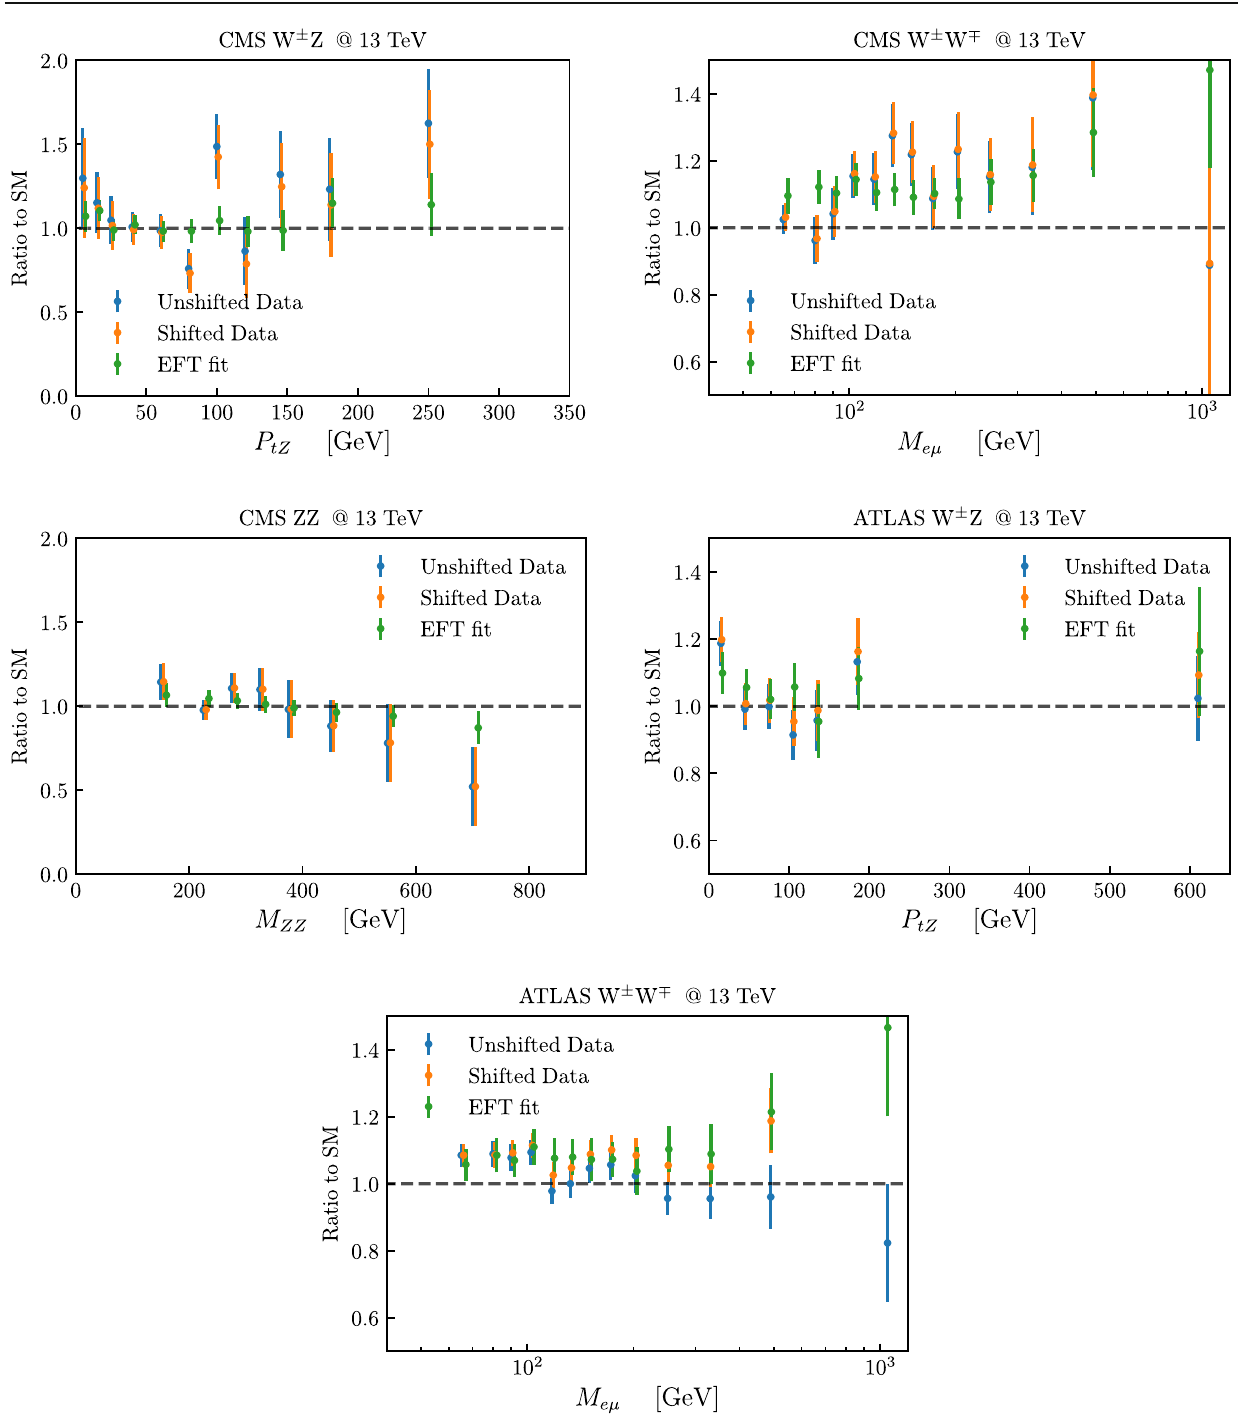
Fig. 17 Comparison between experimental data and best-fit EFT the- ory predictions for the LHC diboson distributions considered in the present analysis. Both the data and the EFT fit results are normalised to